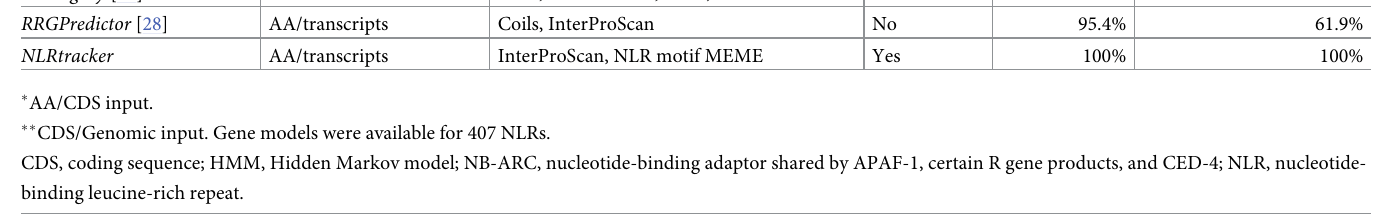
CC-NLRs ( Fig 5B ). Additionally, NLR-Annotator performs similarly on extracted genomic sequence, retrieving 396/407 (97.3%) of RefPlantNLR entries with associated genomic infor- mation ( S2 Fig ). NLGenomeSweeper, which like NLR-Annotator also takes either CDS or genomic sequence as an input, performs considerably worse on genomic input as compared to